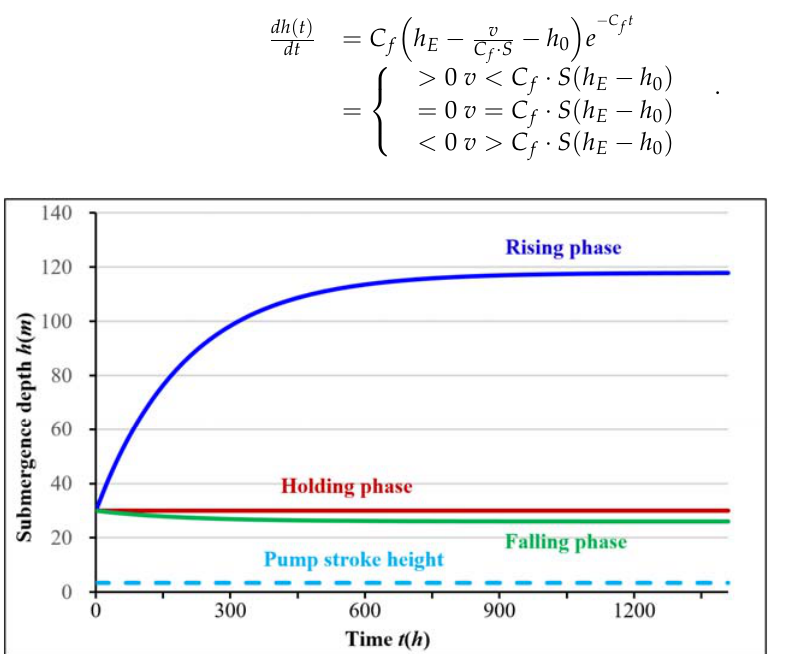
Figure 2. Schematic diagram of three ‐ phase trends of the submergence depth in the full ‐ pumping model.